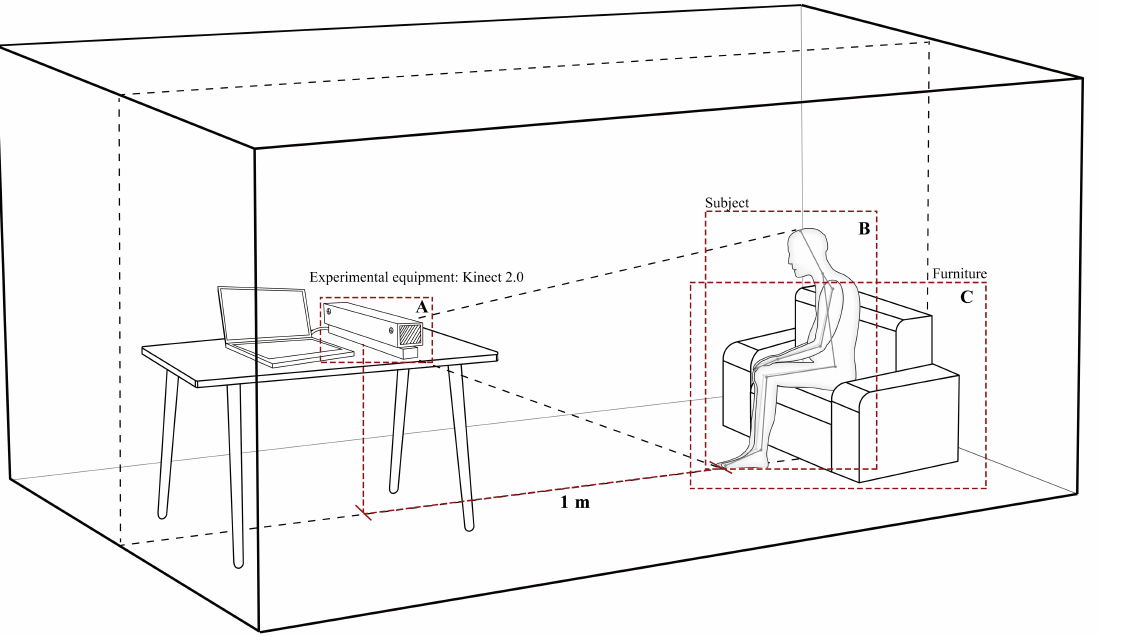
Figure 2. Participant. The experiment was conducted in a quiet and well-lit environment with the equipment set up in a fixed position to identify the process of the subject getting up. A: Kinect, the device used in this experiment. B: The area where the experimental subjects were located. C: The area where the furniture used in the experiment was